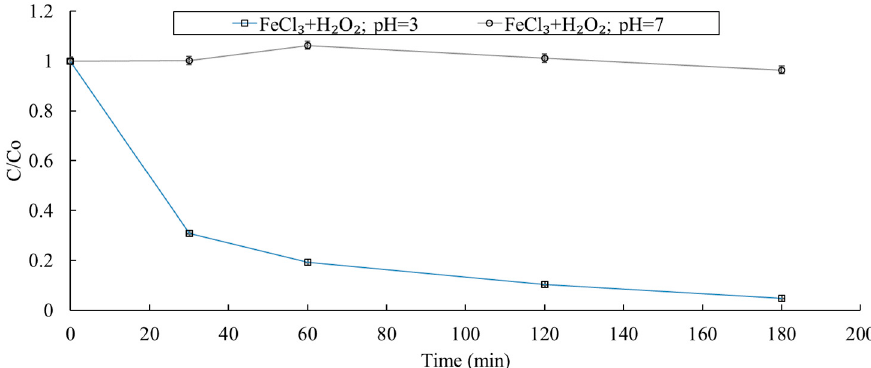
Figure 8. Degradation of sulfolane using Fenton like reagent in synthetic water: [FeCl 3 ] = 1 mM; [H 2 O 2 ] = 15 mM, [sulfolane] = 100 mg / L. The error bars represent the variation of duplicates.